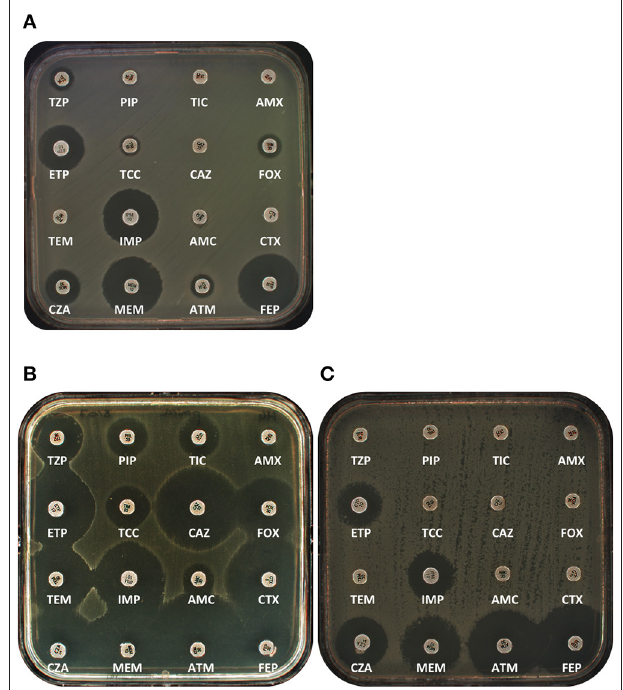
FIGURE 3 | Antibiograms of representative class C & D carbapenemases. (A) ACT-28-producing E. kobei clinical isolate. (B) OXA-23 producing P. mirabilis clinical isolate. (C) OXA-372-producing C. freundii clinical isolates. AMX, Amoxicillin; AMC, Amoxicillin/clavulanate; ATM, aztreonam; CAZ, ceftazidime; CTX, Cefotaxime; CZA, Ceftazidime/avibactam; ETP, Ertapenem; FEP, Cefepime; FOX, Cefoxitine; IPM, Imipenem; MEM, Meropenem; PIP, Piperacillin; TCC, Ticarcillin/Clavulanate; TEM, Temocillin; TIC, Ticarcillin; TZP,